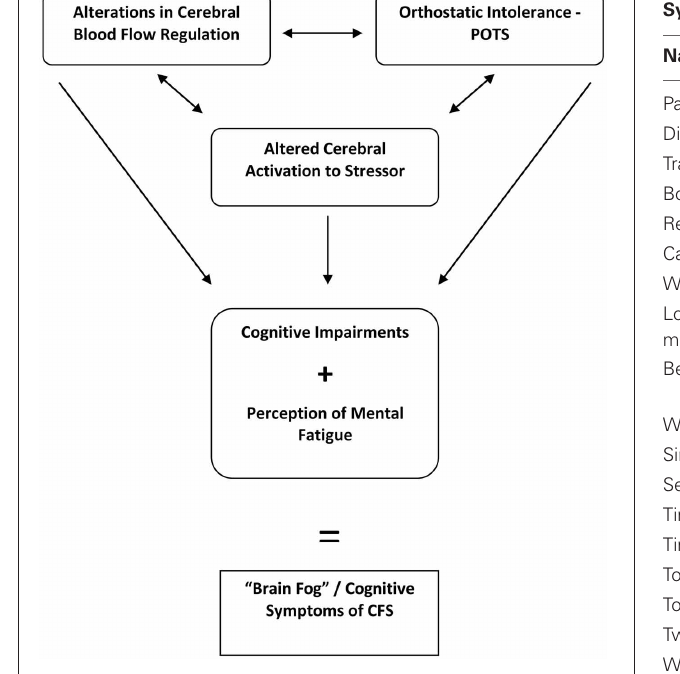
FIGURE 1 | Interactions between multiple factors may contribute to the cognitive symptoms subjectively described as “brain fog” in Chronic Fatigue Syndrome (CFS). POTS, Postural Tachycardia Syndrome.